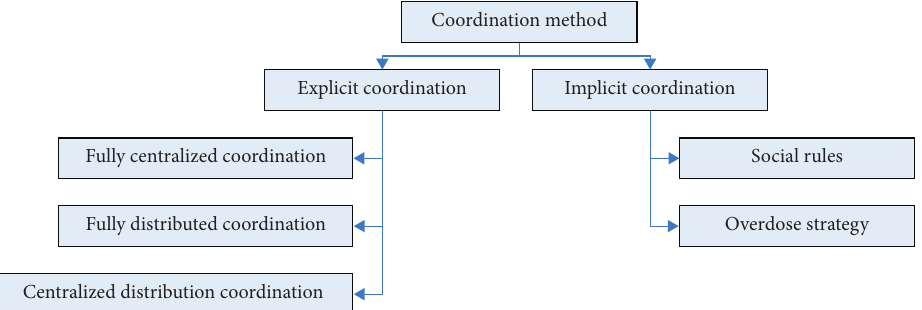
Figure 1: Coordination method of the multiagent system.